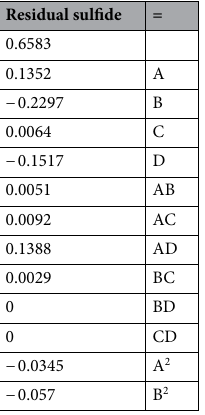
Table 4. Final equation for model in terms of coded factors.